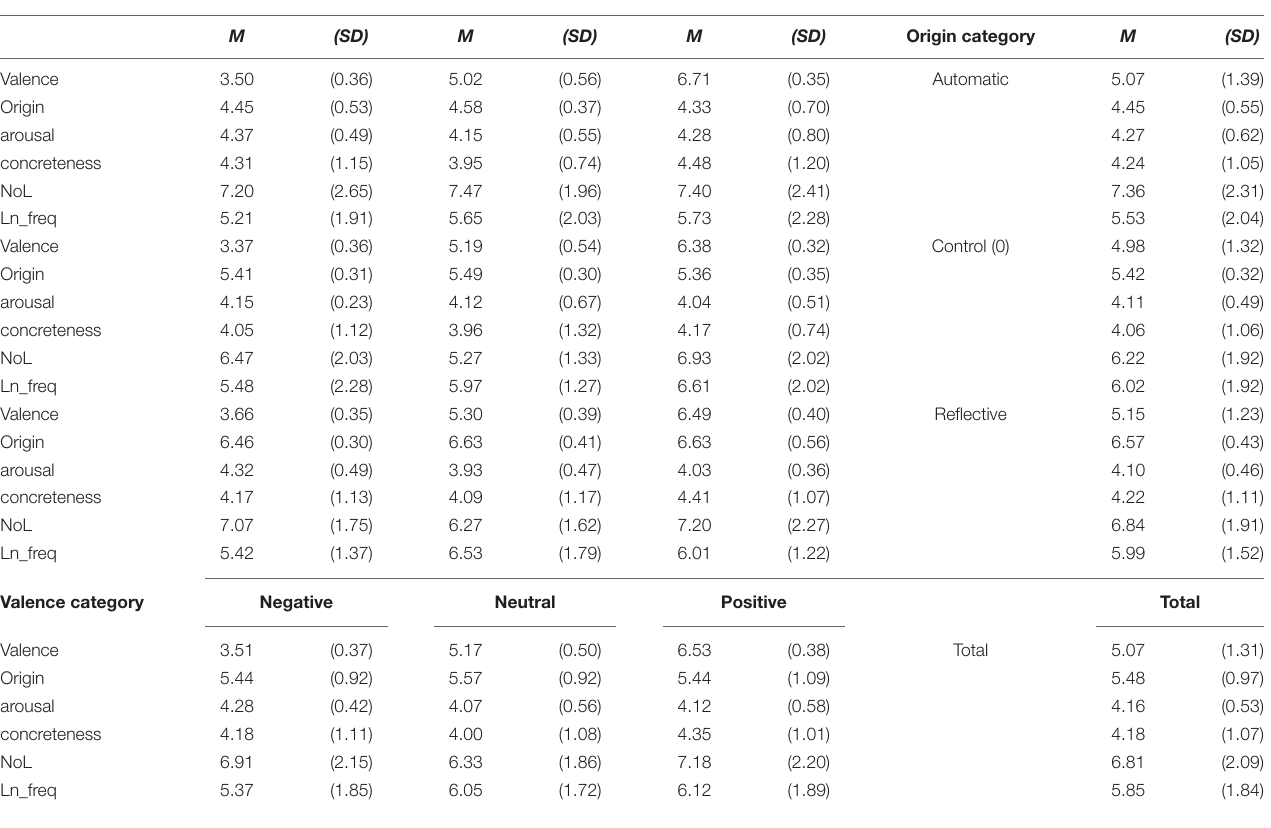
TABLE 1 | Descriptive statistics ( M , SD ) for groups of words used in factorial